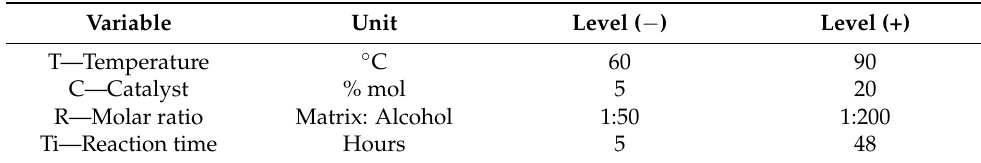
Table 6. 2 4 factorial planning variables and their levels.